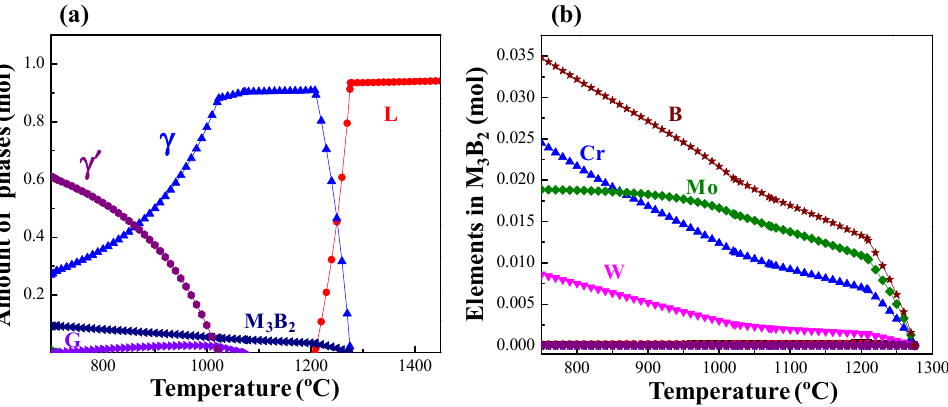
Figure 8. Thermo-Calc predictions for the ASZ of brazing joints based on the TTNi8 database: ( a ) Contents of phases at different temperatures ( b ) Contents of elements in M 3 B 2 phase at different temperatures.